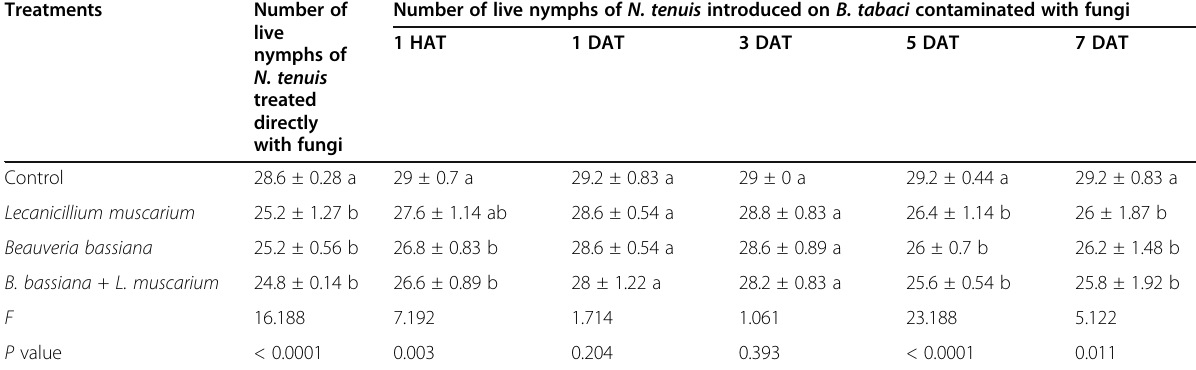
Table 3 Mean number of live nymphs of Nesidiocoris tenuis (±SD) treated with entomopathogenic fungi